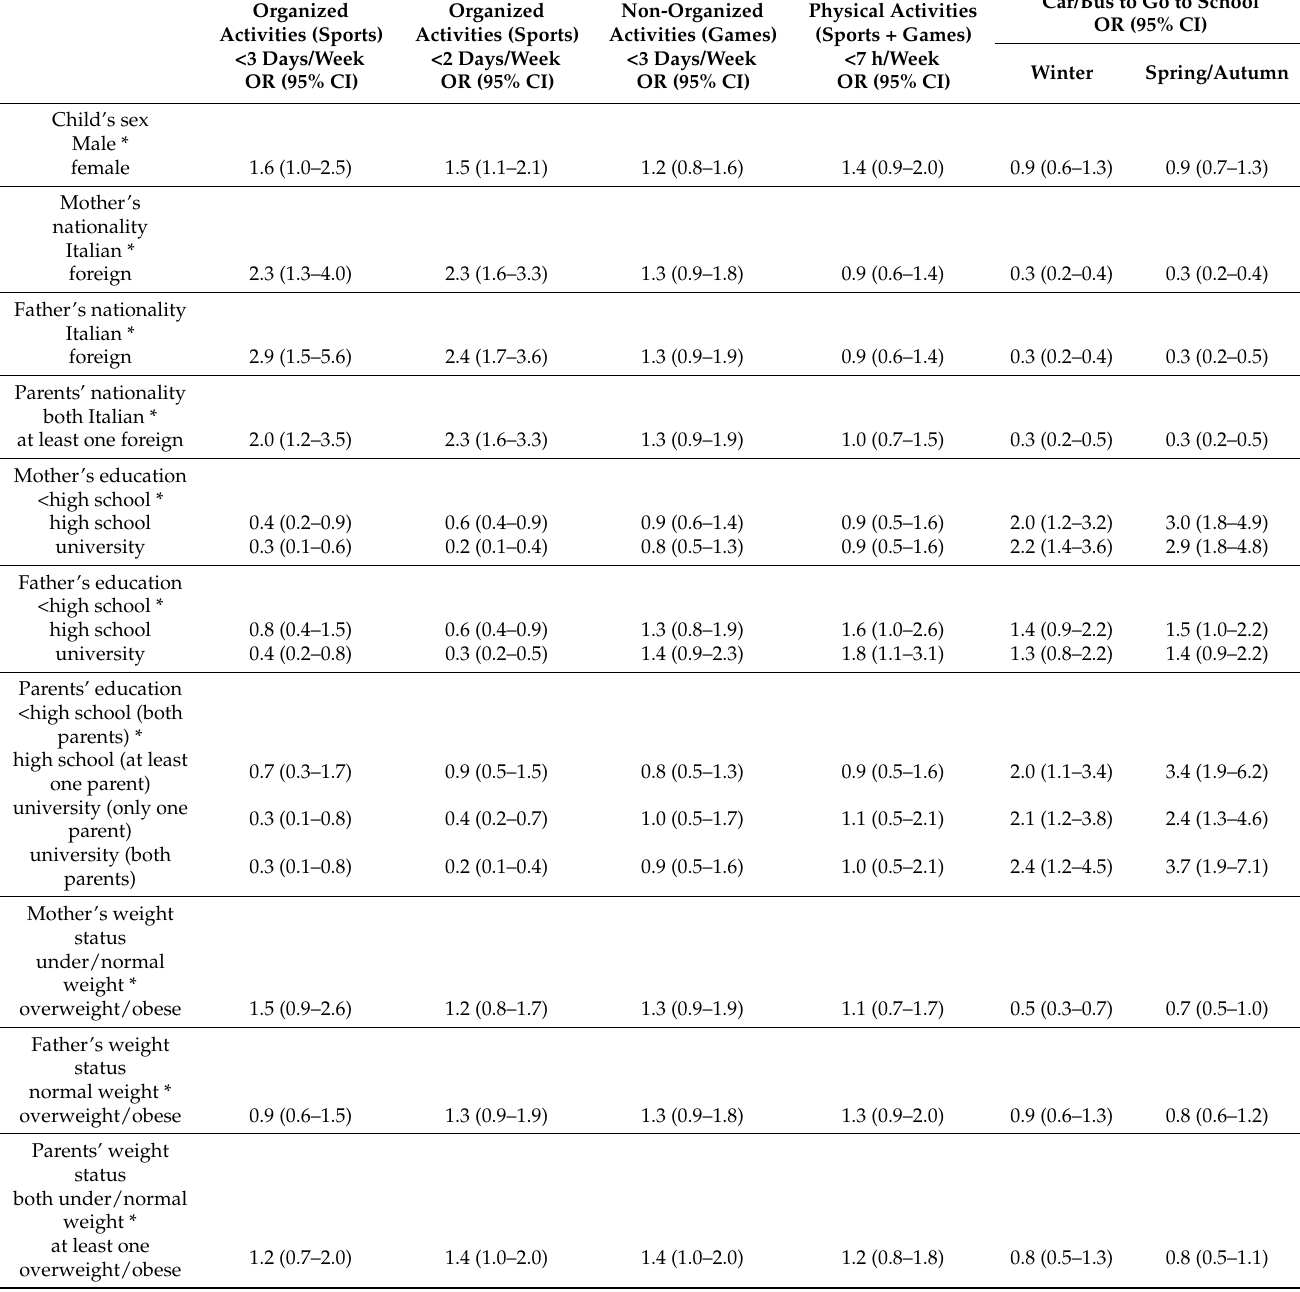
Table 2. Univariate logistic regression for outcomes of physical